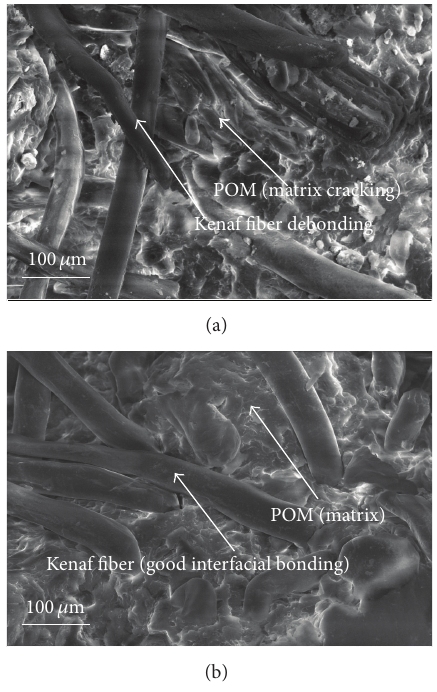
Figure 5: FESEM micrograph of POM/kenaf composite of (a) weathered samples and (b) controlled